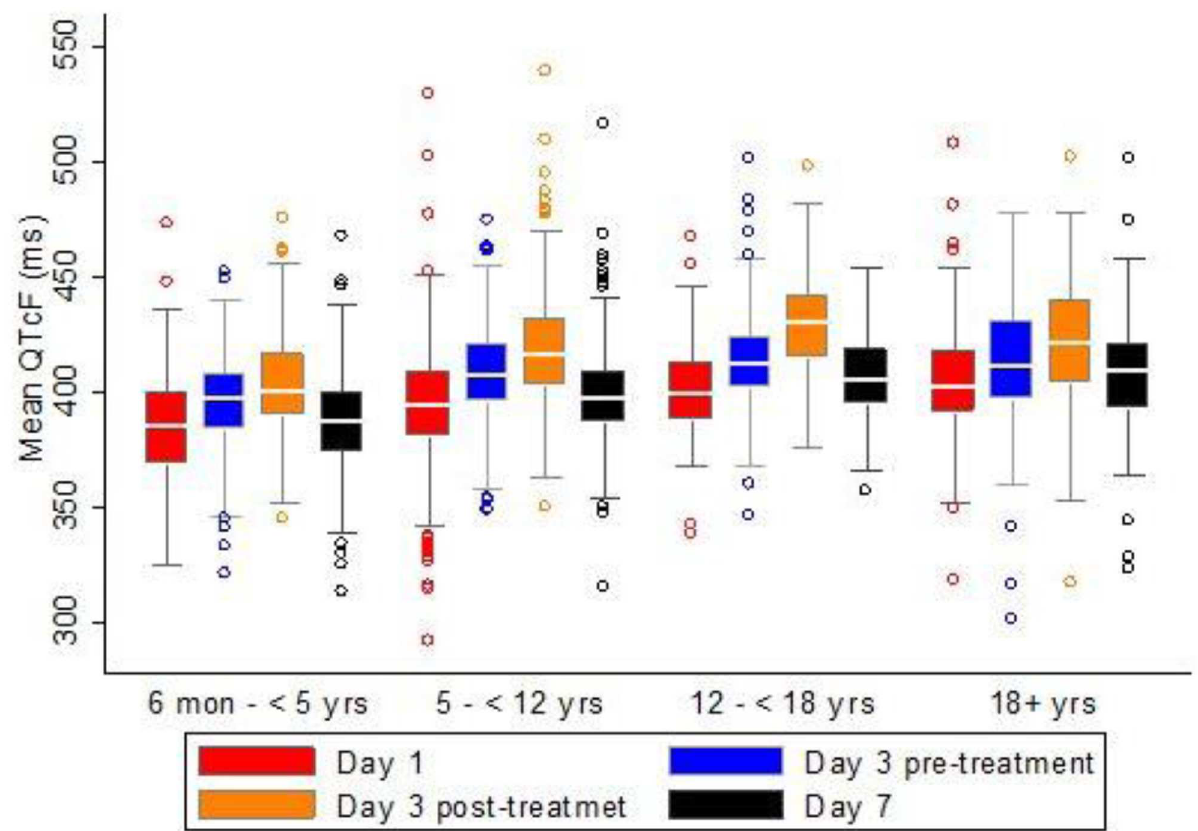
Fig 3. Mean QTcF over time by age